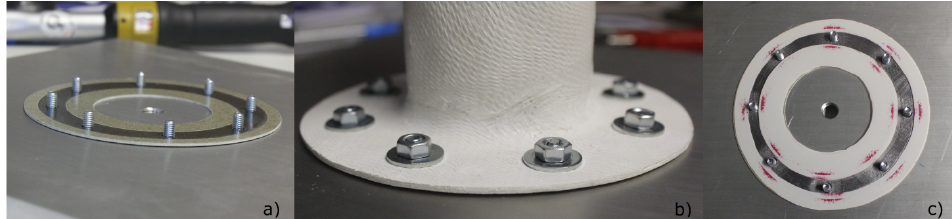
Figure 9. The graphite gasket surrounded by mica ( a ) is used to seal the flange connection between the combustion chamber and the injector head ( b ), but shows a highly inhomogeneous distribution of force, which is visible through the red imprints of the indicator foil ( c